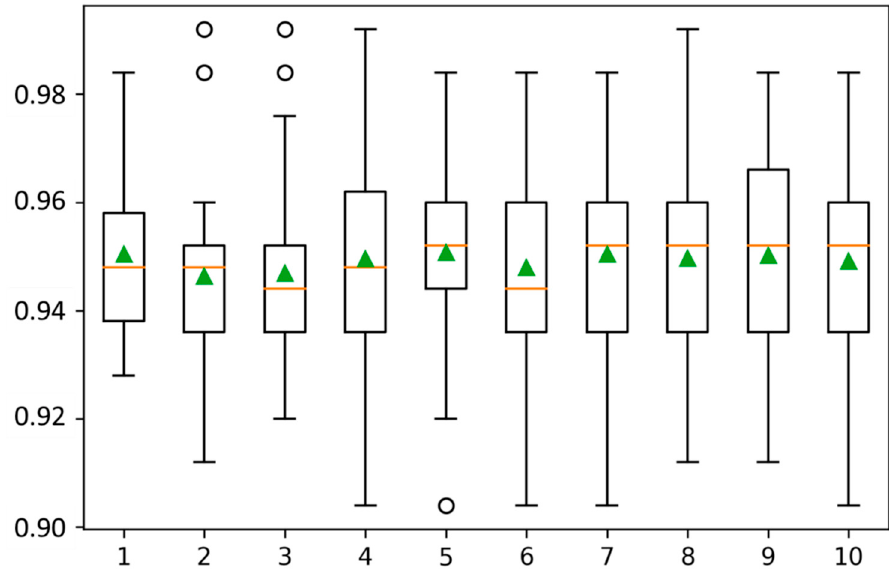
Figure 3. Accuracy scores of all 10 folds for 10-fold cross-validation. The circles represent outliers.